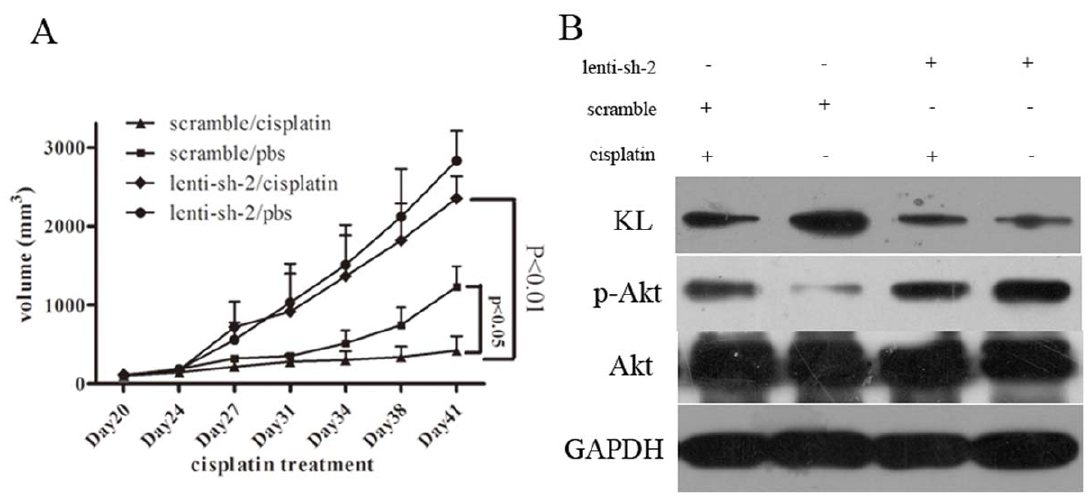
Figure 5. The apoptosis of the cells and the invivo experiment. A : Apoptosis of the cells analyzed by Flow cytometry. B: Apoptosis of the cells was conducted by DAPI staining. Condensed chromatin was examined by a fluorescence microscopy. C : In vivo chemoresistance assay of klotho knockdown cells. Xenograft tumor volumes in mice treated with cisplatin or physiological saline are shown. Tumor volume is presented as the mean 6 SD. D : Expression of klotho and p-Akt in tumor tissue from the